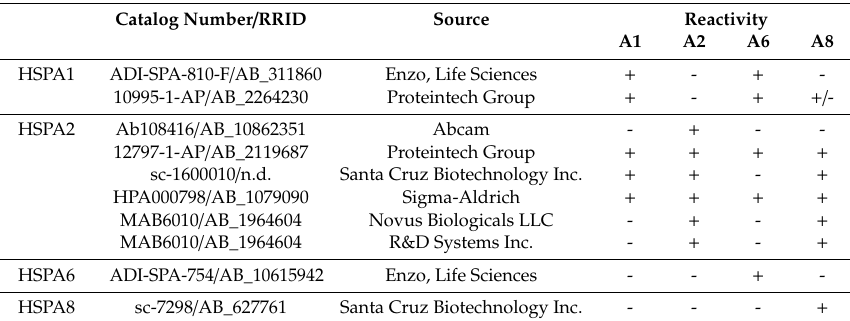
Table 2. Cross-reactivity of anti-HSPA